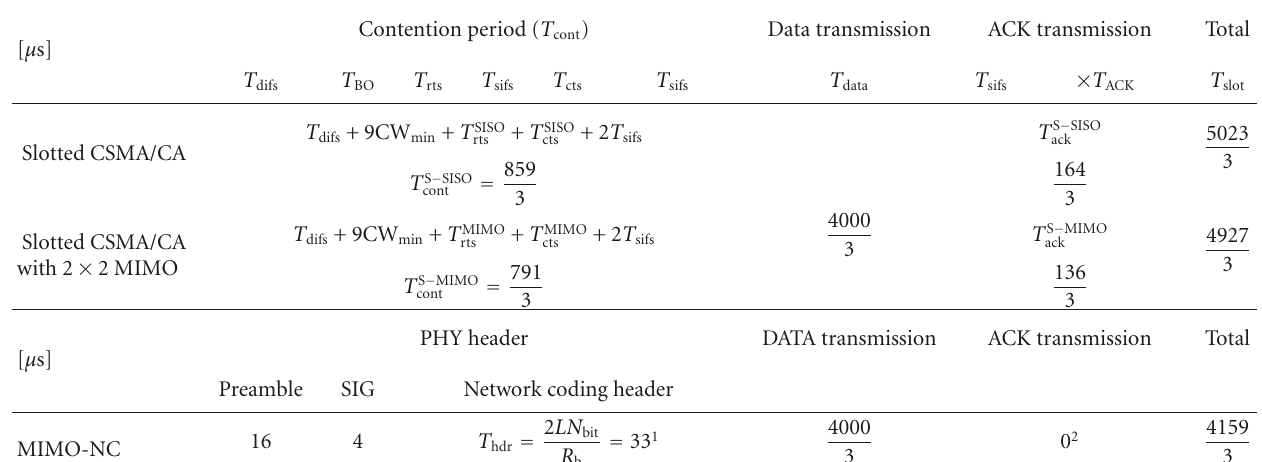
Table 4: Time slot configuration of slotted CSMA/CA and MIMO-NC (unit: μs